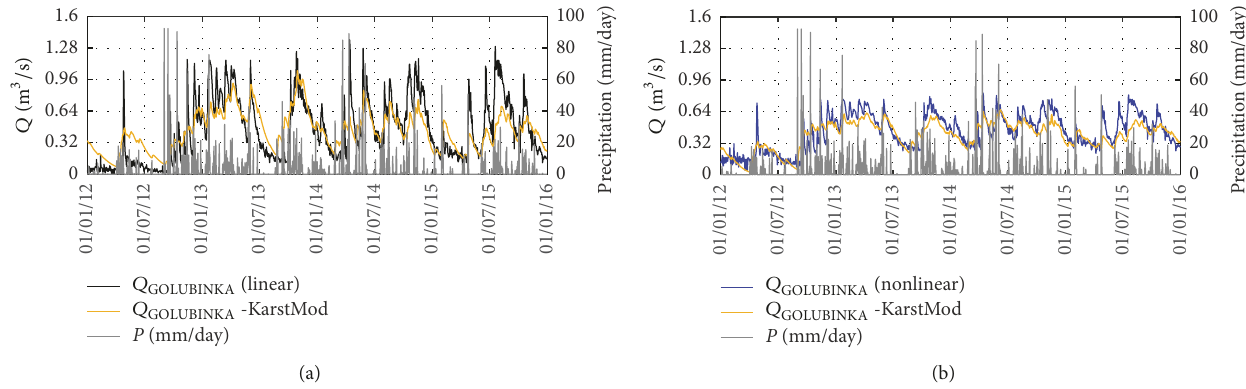
Figure 7: Calculated discharges of the Golubinka spring obtained by the KarstMod model simulation, and the linear ( 𝑄 = 𝐾 𝑚 ⋅ 𝑚 ) and nonlinear ( 𝑄 = 𝐾 𝑚 ⋅ sqrt (𝑚) ) approach from the first step of the methodology .